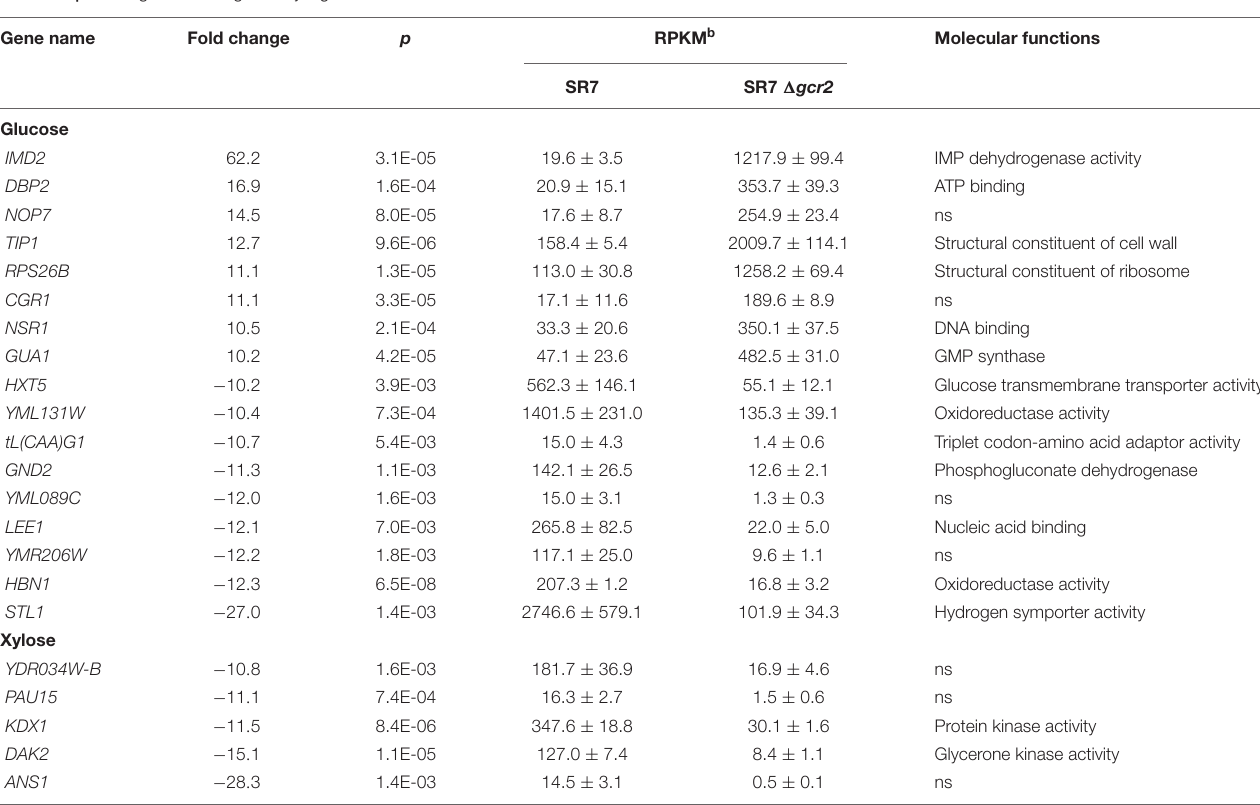
TABLE 3 | Most significant DE genes by (cid:49) gcr2 a